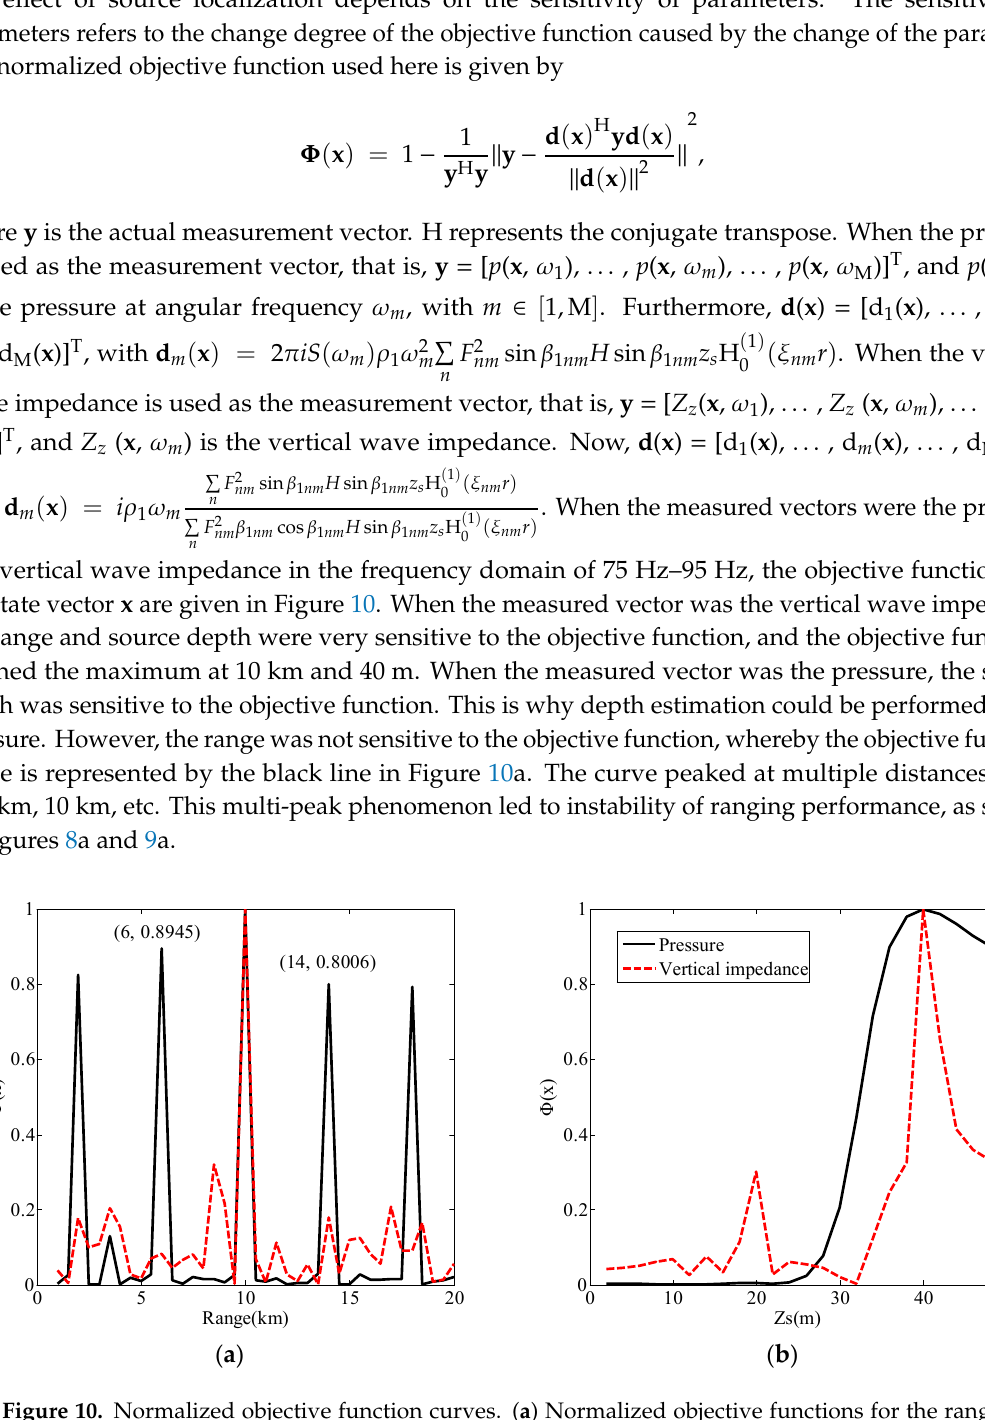
Figure 9. Localization results for pressure as the measured vector. ( a ) Range estimation result with pressure as the measured vector; ( b ) source depth estimation result with pressure as the measured vector.